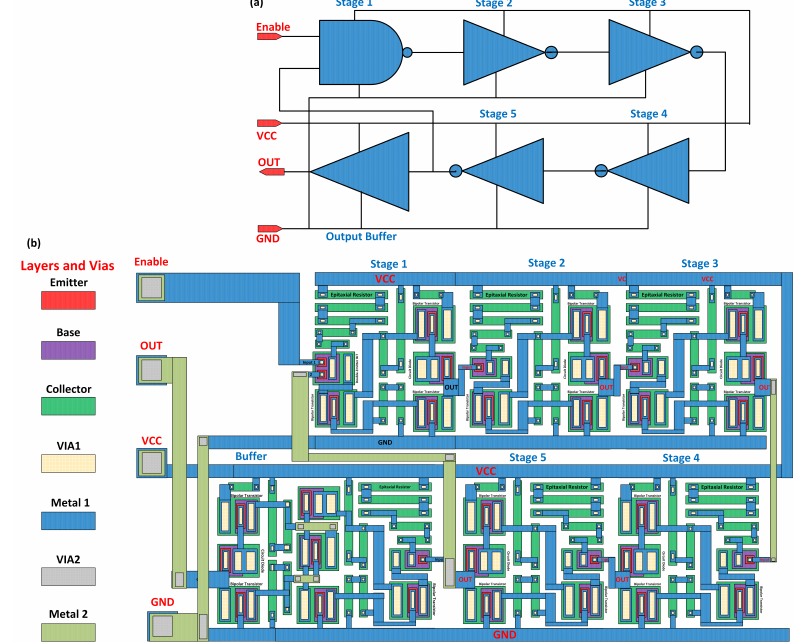
Figure 5. SiC ICs monolithic integration using SiC PDK. 4 Inverters, 2-input NAND and a Buffer standard cells are integrated as an illustration ( a ) 5-stage ring-oscillator gate level implementation using PDK gate library ( b ) 5-stage ring-oscillator place and route using PDK standard cell